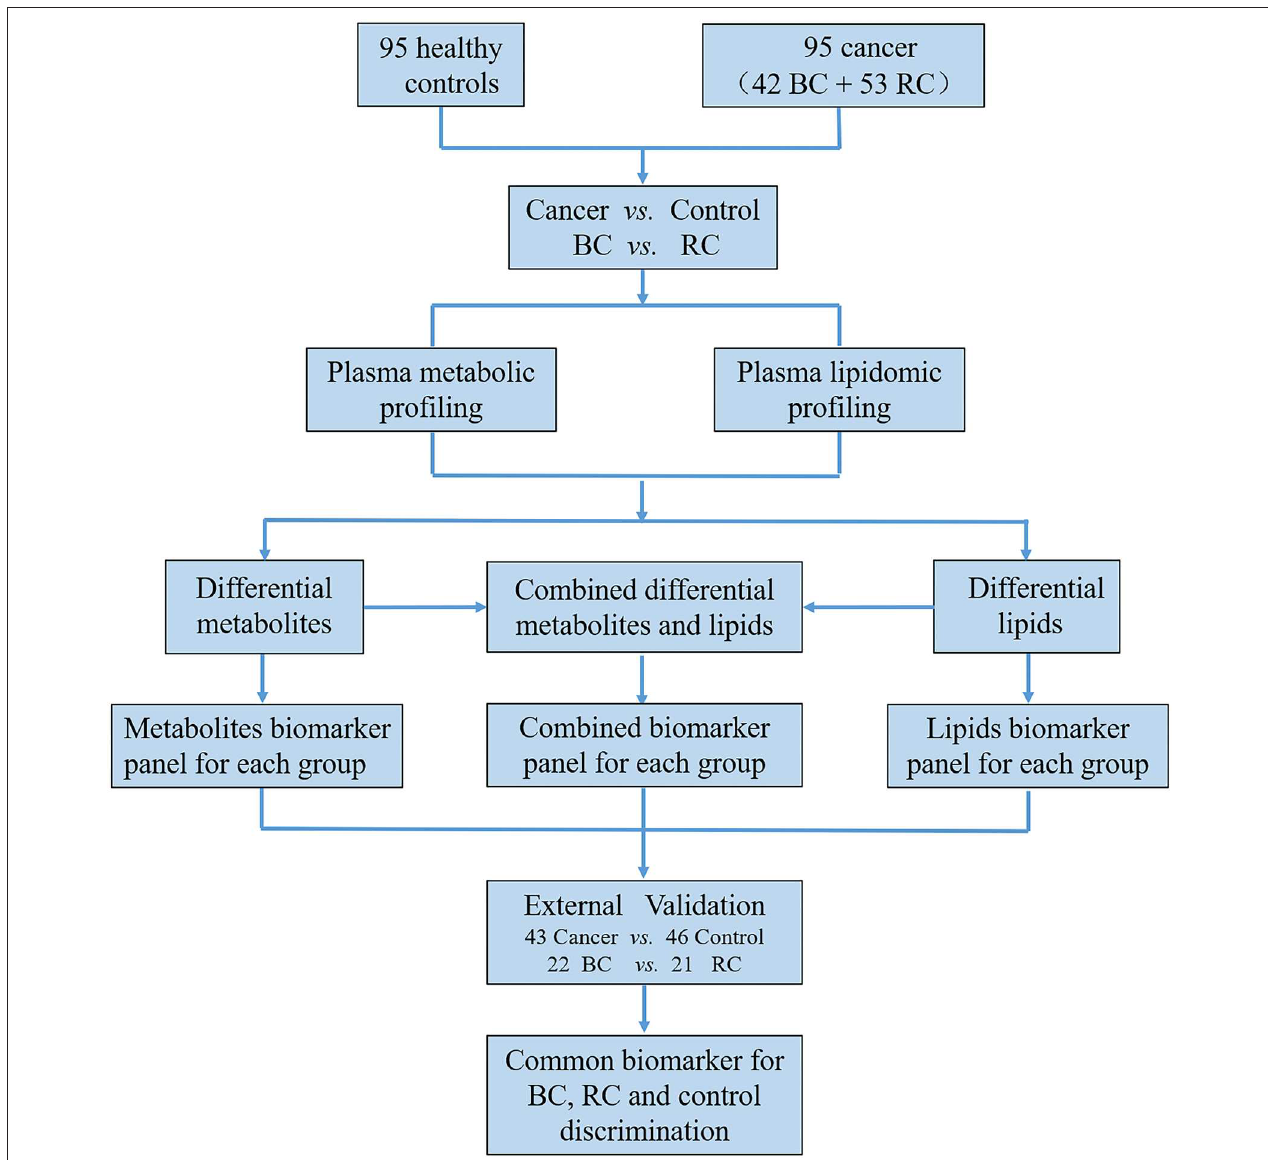
FIGURE 1 | The workflow of this